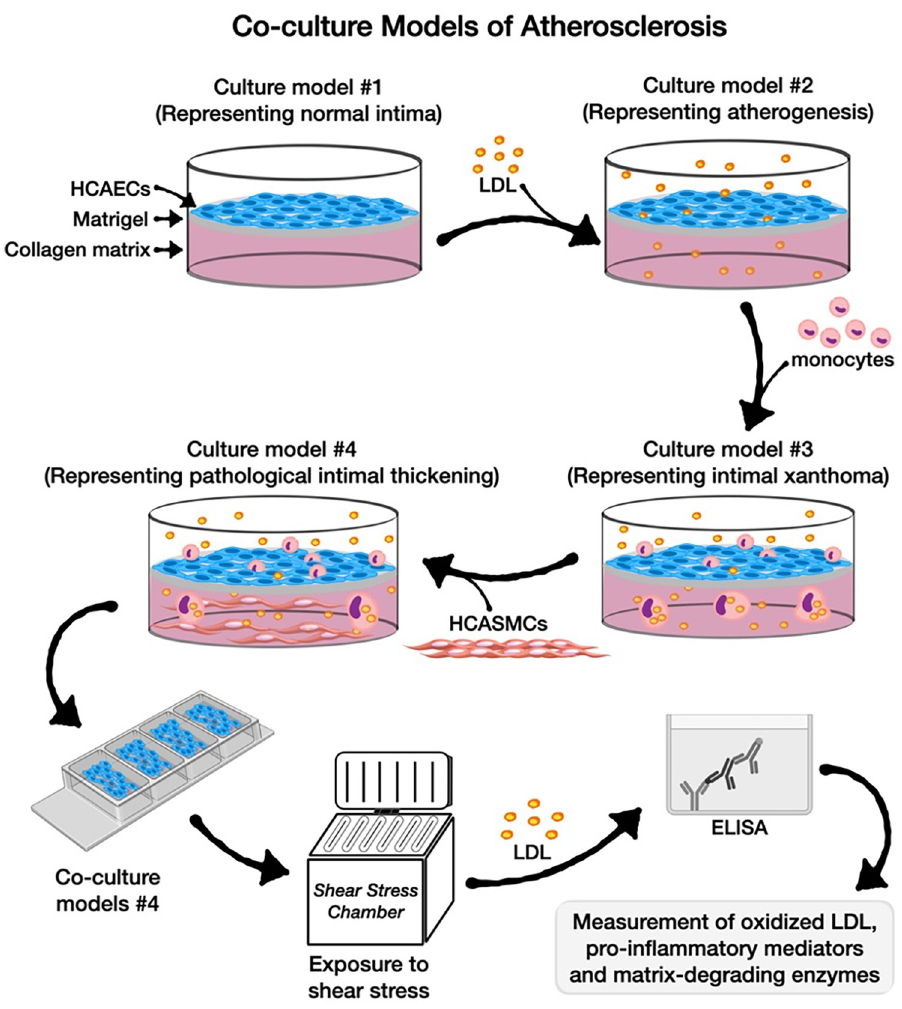
Fig 1. Graphical illustration of the co-culture models and study design. HCAECs: human coronary artery endothelial cells; HCASMCs: human coronary artery smooth muscle cells; LDL: low-density